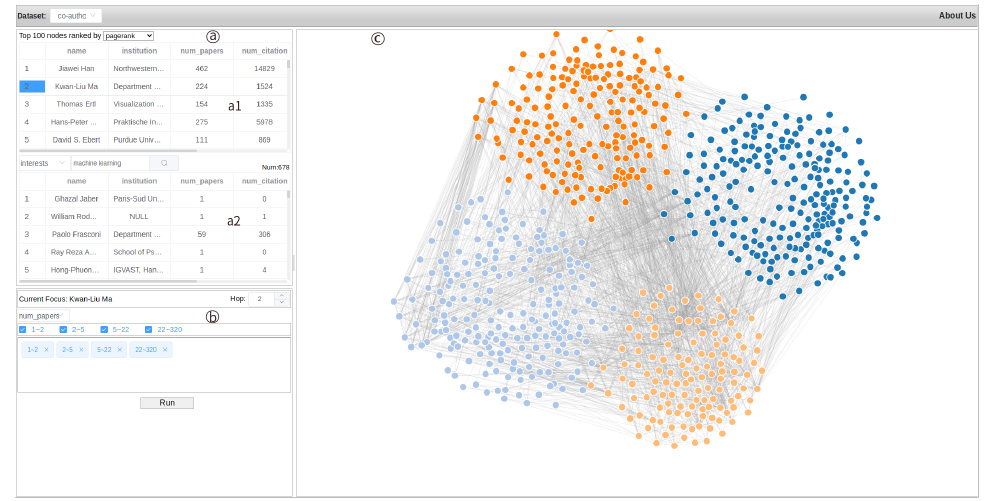
Figure 2. Visual system for user interaction with FDAC. (a) The focus selection view with (a1) the automatic screening by the system and (a2) the search view. (b) The attribute selection view. (c) The layout result